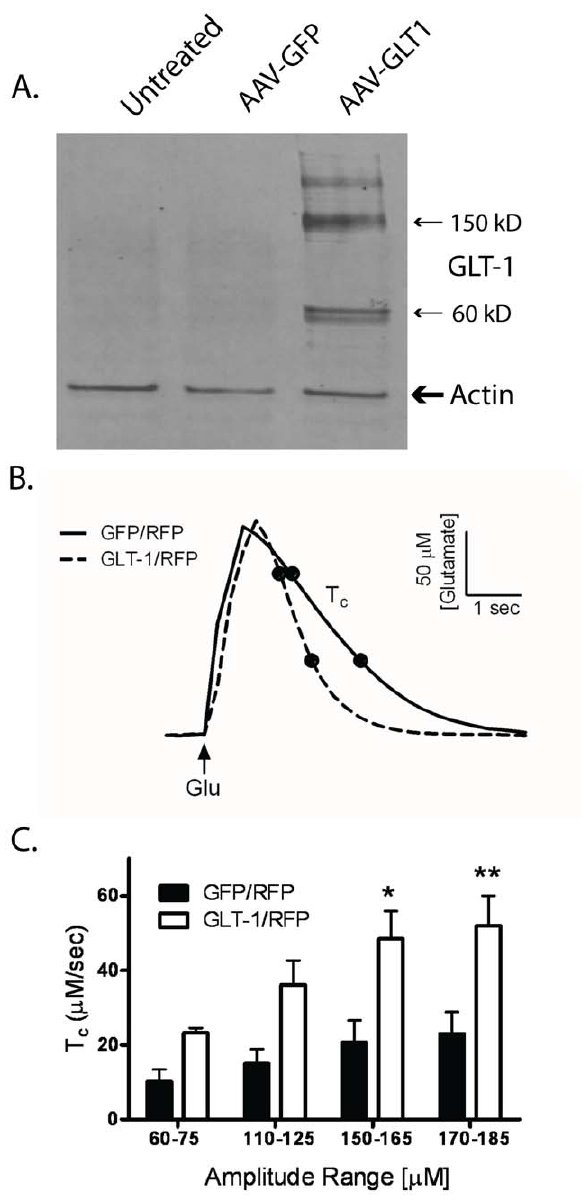
Figure 1. Characterization of AAV-GLT1 invitro and invivo . (A) Western blot analysis for GLT-1 protein in HEK293 cells that were transfected with the AAV-GLT1 packaging plasmid for 24 hours. GLT-1 appears as two prominent bands 150 kD and 60 kD [21,22]. (B) Representative graphs showing time course of glutamate signals (amplitudes in 170–185 uM glutamate range) and the faster glutamate clearance rate in the striatum of animals injected with AAV-GLT1 compared to AAV-GFP. (C) Glutamate clearance (Tc) in the striatal hemisphere treated with AAV-GLT1 was significantly increased com- pared to the AAV-GFP -treated hemisphere. * p , 0.05, ** p ,